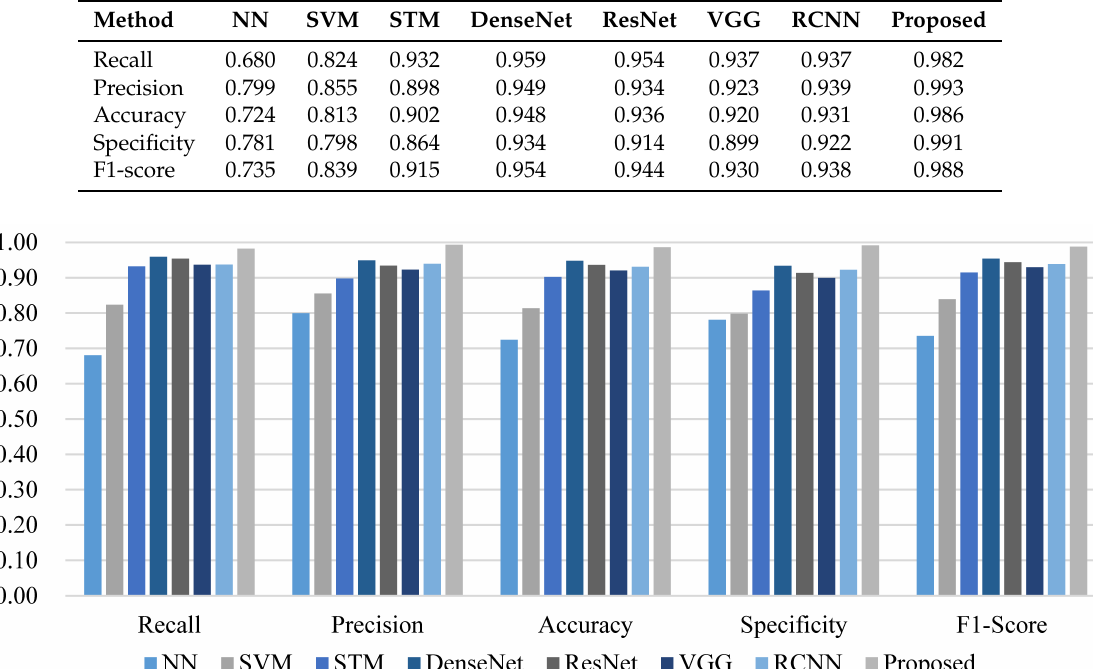
Table 3. Classification performance of different methods for blister detection.